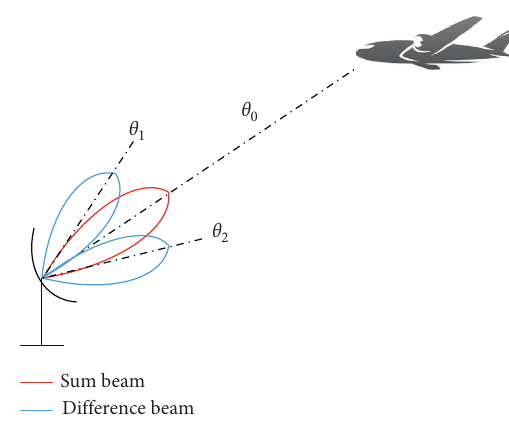
Figure 3: Sum and difference beam